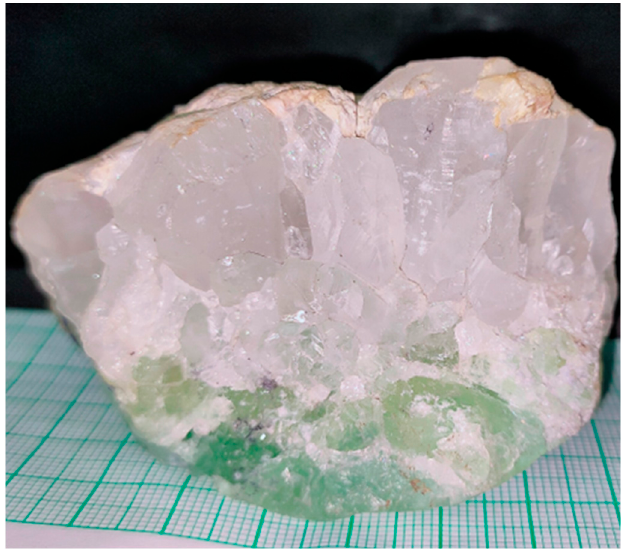
Figure 12. Photograph of the quartz fluorite composite procured from an amygdaloidal basalt from Deccan Traps, India.